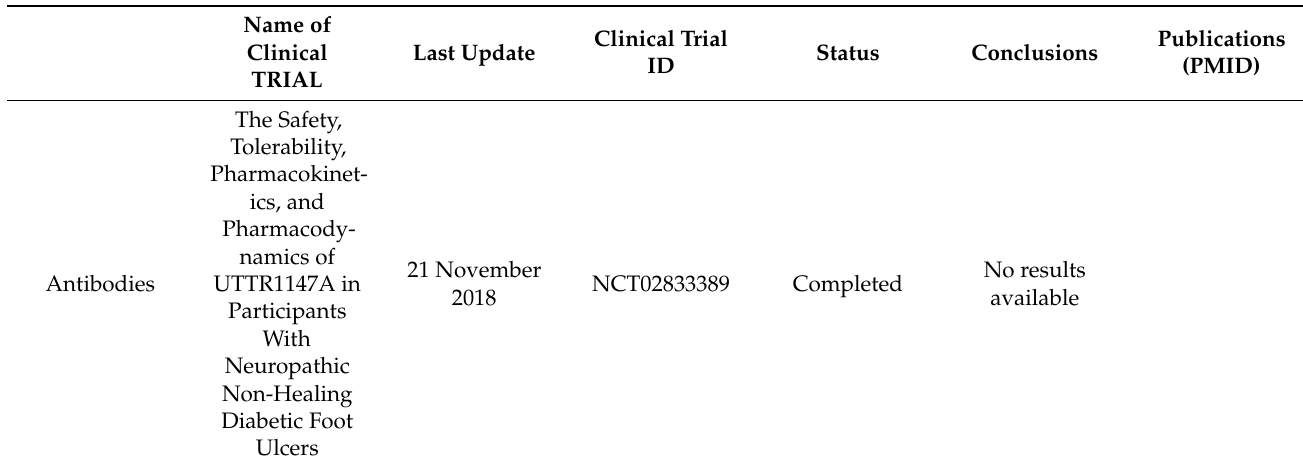
* Table data taken from clinicaltrials.gov, updated on 17 January 2021. Key search words included: “Diabetic Foot Ulcer” and “Impaired Wound,” as well as associated subcategories.